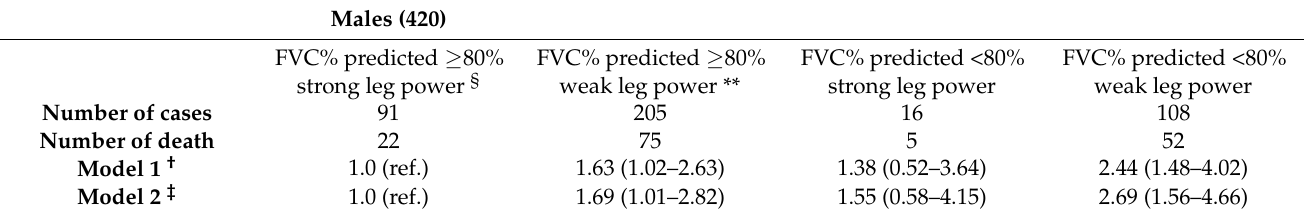
Table 4. The relationship between the leg power (2 groups), FVC% predicted (2 groups), and mortality